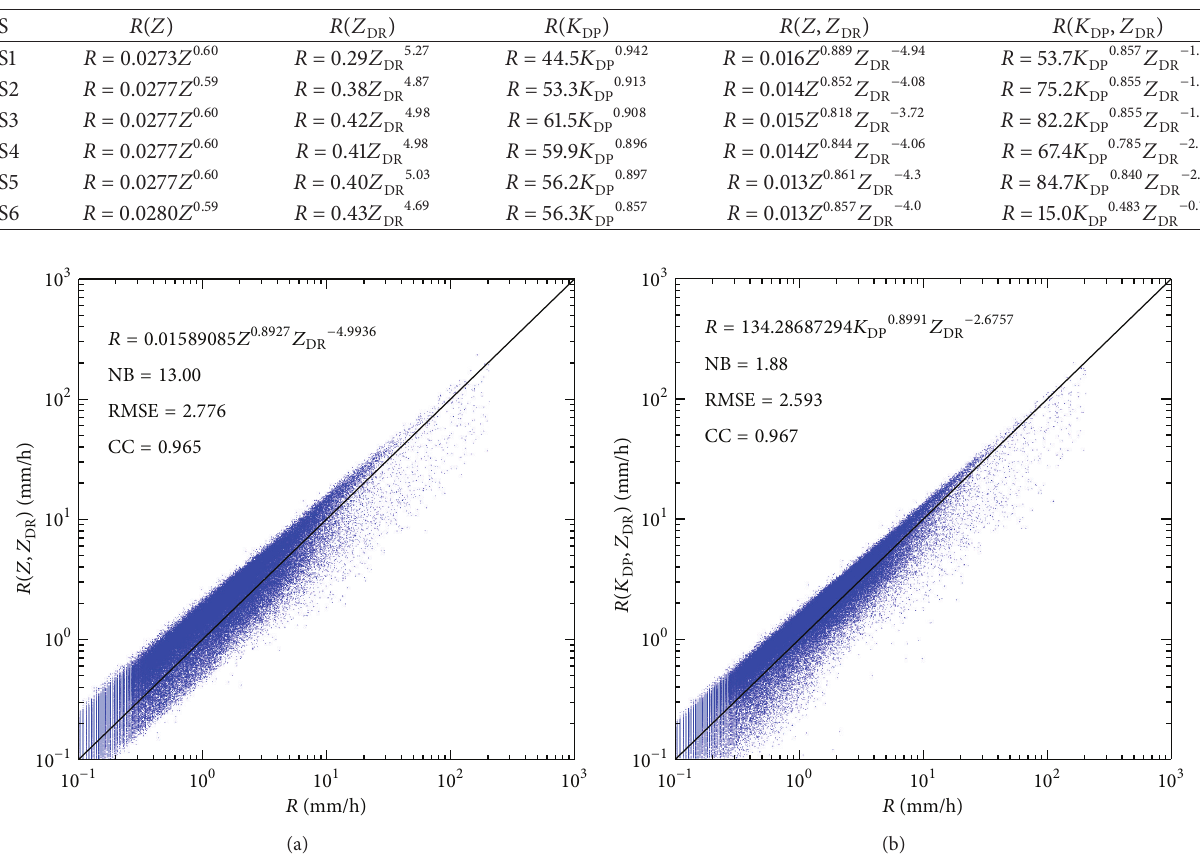
) , 𝑅(𝐾 ) , 𝑅(𝑍,𝑍 ) , and 𝑅(𝐾 , 𝑍 ) with different raindrop shape assumptions. DR DP DR DP DR